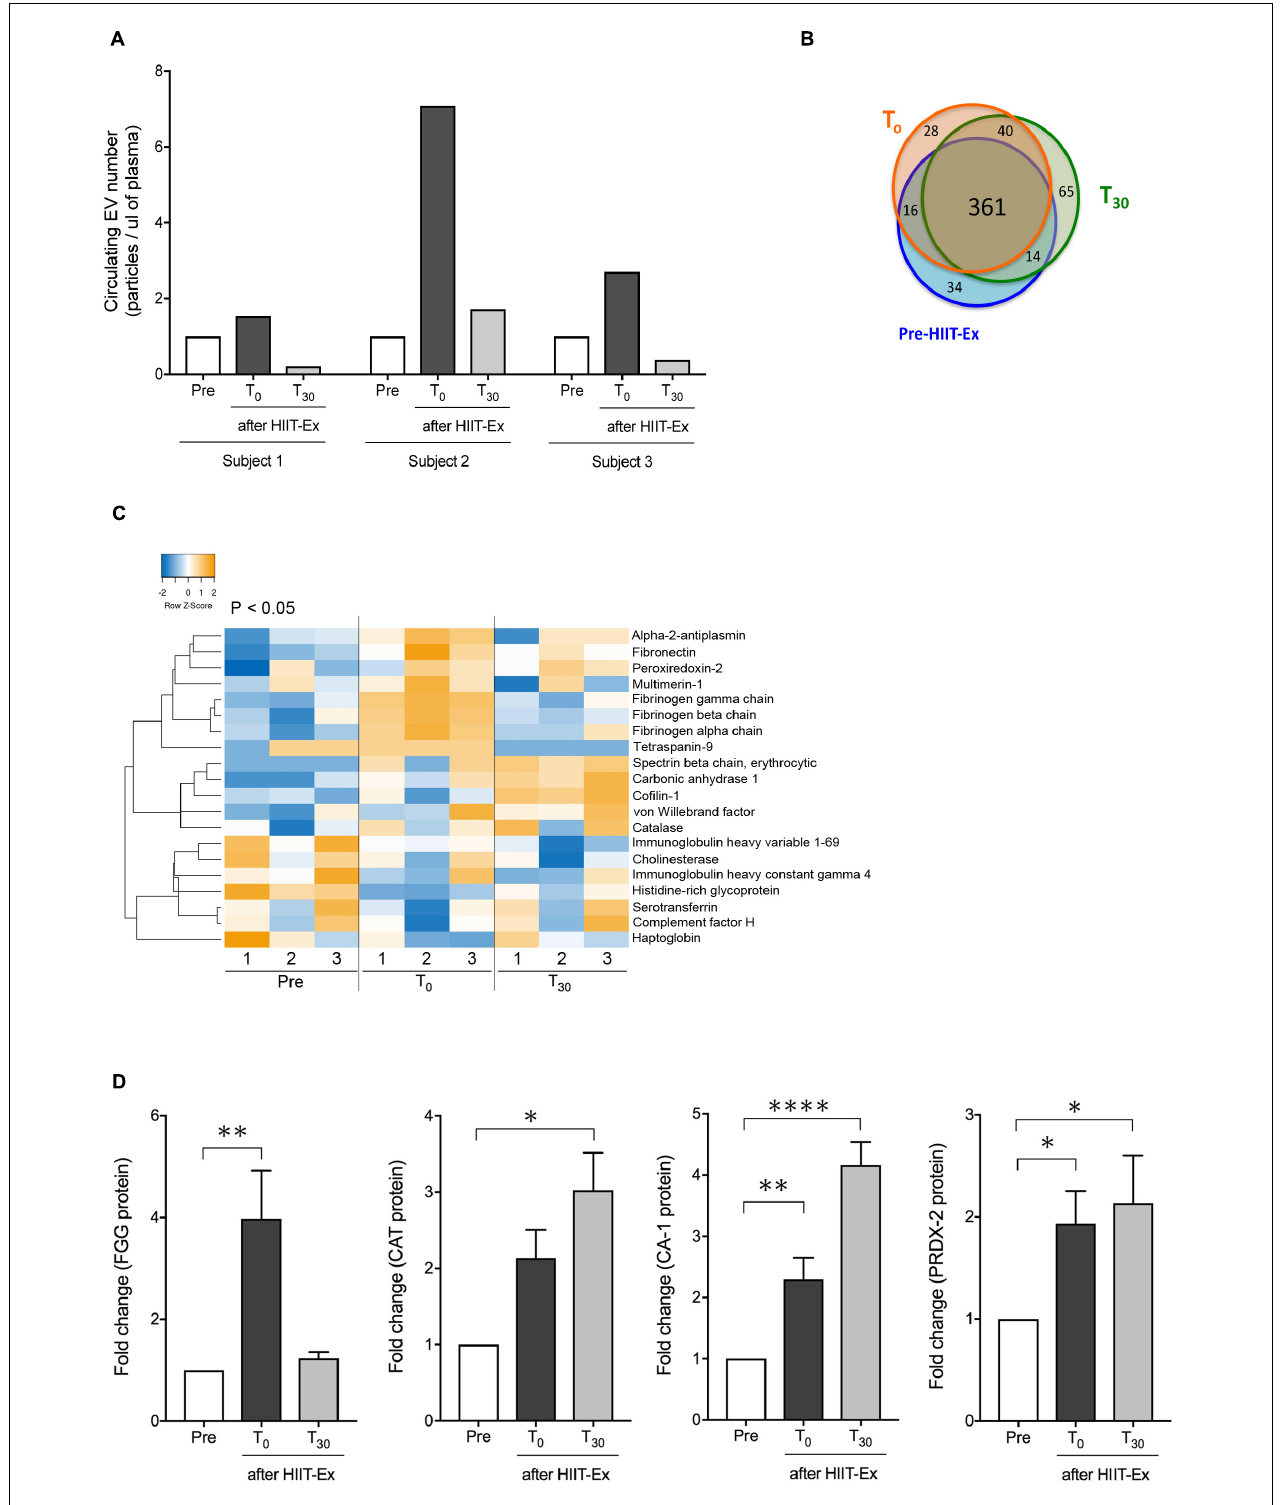
FIGURE 4 | Detected EV proteins. (A) Changes in circulating EV number at pre-HIIT-Ex, T 0 , and T 30 in three subjects using proteomic analysis. (B) Detected protein number at pre-HIIT-EX, T 0 , and T 30 . (C) Heatmap of identified proteins with significant changes in isolated circulating EVs at pre-HIIT-Ex, T 0 , and T 30 . (D) Change in EV protein values at pre-HIIT-Ex, T 0 , and T 30 . Fibrinogen gamma chain (FGG), catalase (CAT), carbonic anhydrase (CA-1), and peroxiredoxin II (PRDX-II). Kruskal-Wallis test was used for evaluating statistical significance among the three sampling points. ∗∗∗∗ p < 0.0001, ∗∗ p < 0.01, ∗ p < 0.05. Pre: pre-HIIT-Ex.